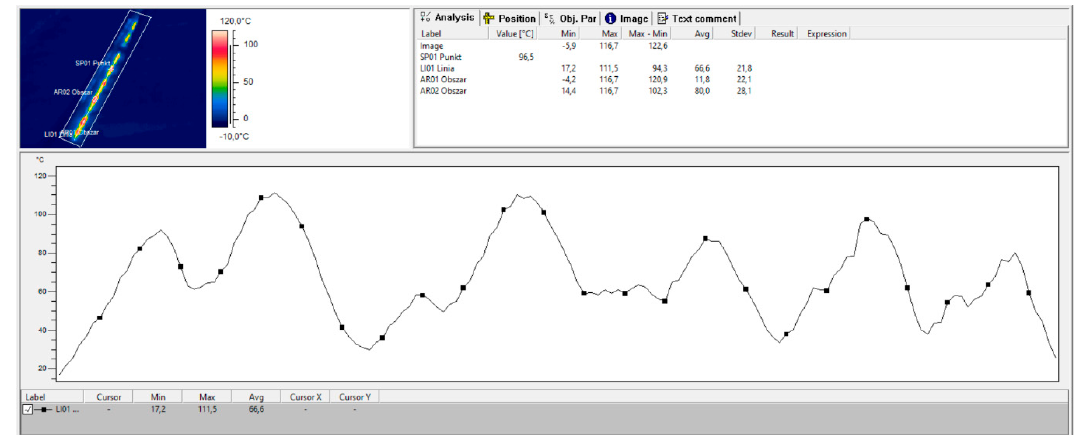
Figure 13. Thermogram IR_0145, rain900 colour palette, the temperature profile for line L01 tool is shown (source: authors).